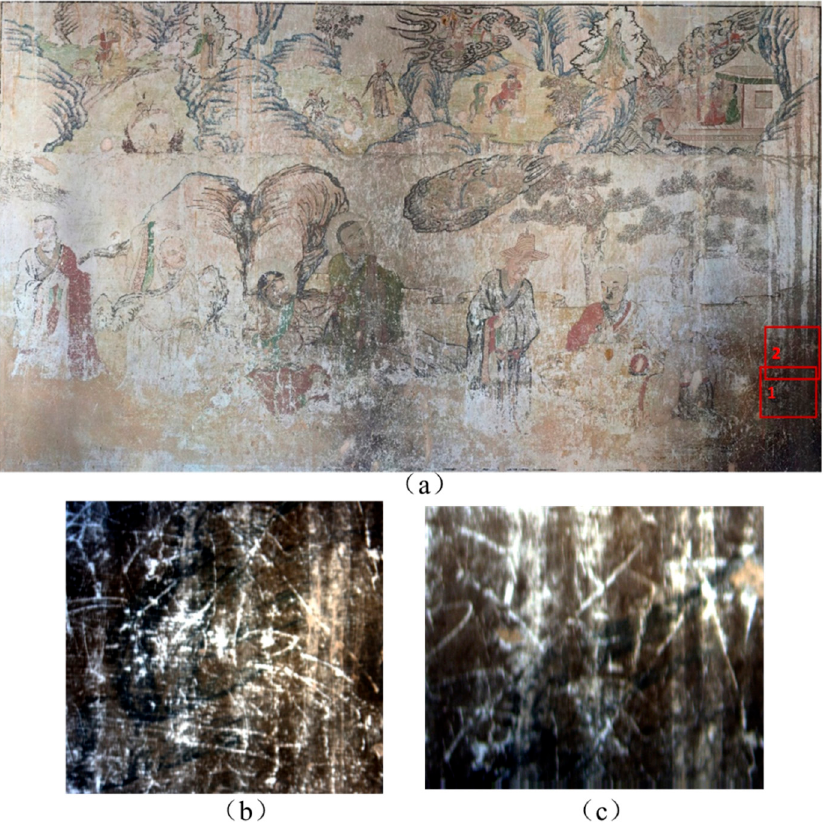
Figure 1. The image of the mural and the two study areas. ( a ) The complete image of the mural; ( b ) the image of the first study area; ( c ) the image of the second study area.